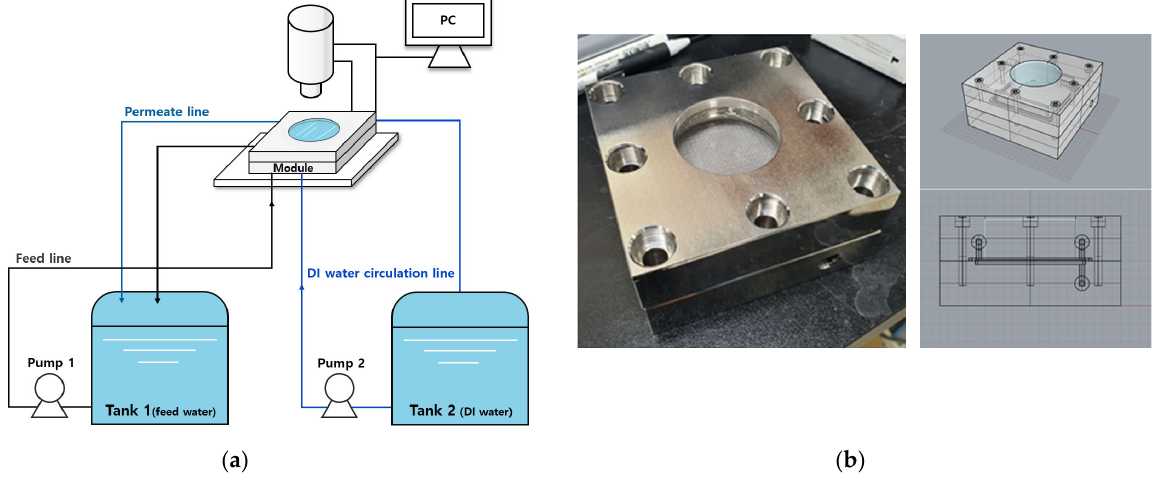
Figure 1. ( a ) Schematic diagrams of RO test apparatus. ( b ) Membrane module for OCT analysis. This test system consisted of a cross ‐ fl ow membrane cell with a fl ow channel (dimensions 60 mm × 60 mm × 3 mm). A membrane coupon was put into the membrane